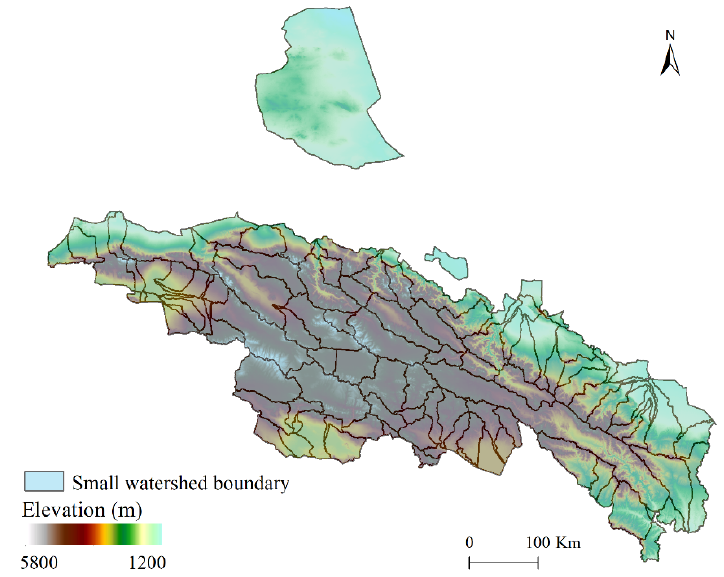
Figure 2. Small watershed division of the Qilian Mountains.